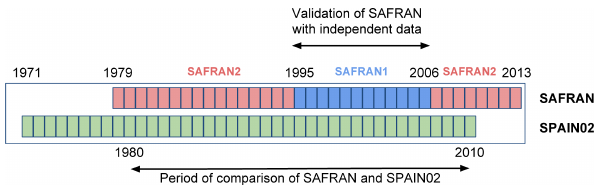
Figure 2. The data availability for SAFRAN and